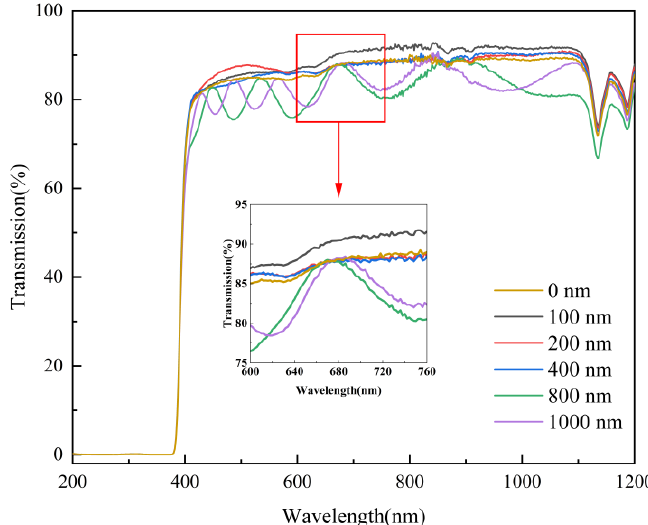
Figure 7. Transmittance of film samples with different film thicknesses.